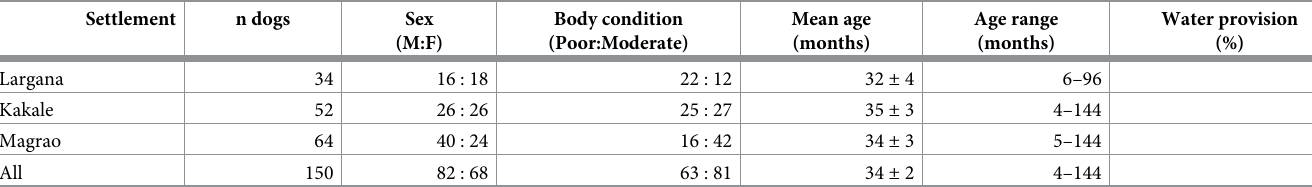
Table 1. Summary of dog characteristics in three settlements in Chad. Data are from all collared dogs (n = 150), but some dogs have missing data for individual charac- teristics. Water provision is the proportion of households which reported providing water for animals. Settlement